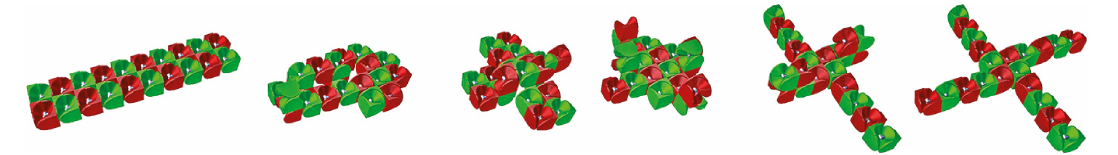
Figure 10: Self-recon fi guration process by the D0L-system in (2) without environmentally sensitive recon fi guration.